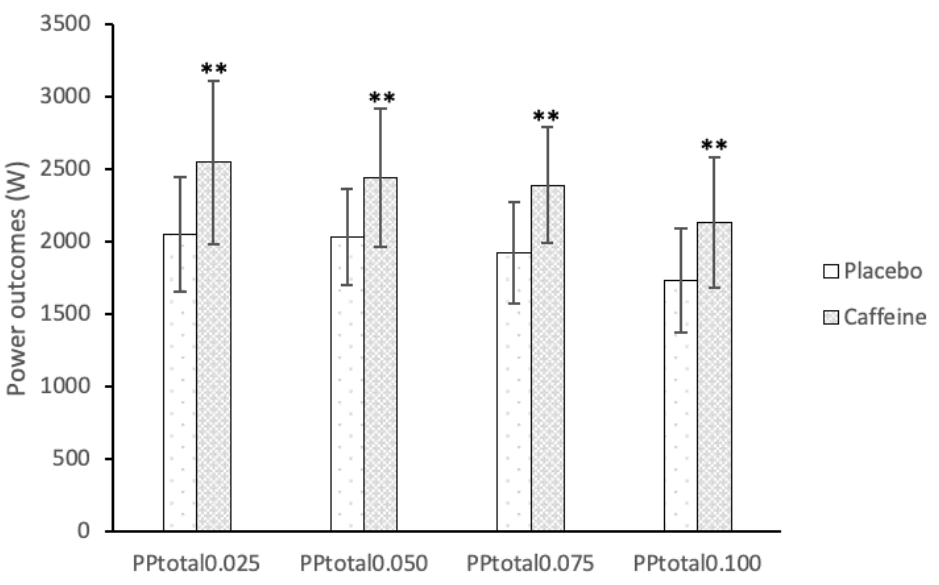
Figure 4. Effects of caffeine ingestion on total peak power (PP total ) outcomes at different inertias when compared to the placebo condition. ** Significant differences ( p < 0.01). Table 2. Effects of caffeine ingestion on concentric (CON) and eccentric (EEC) peak power (PP) outcomes (W) at different inertias compared to the placebo